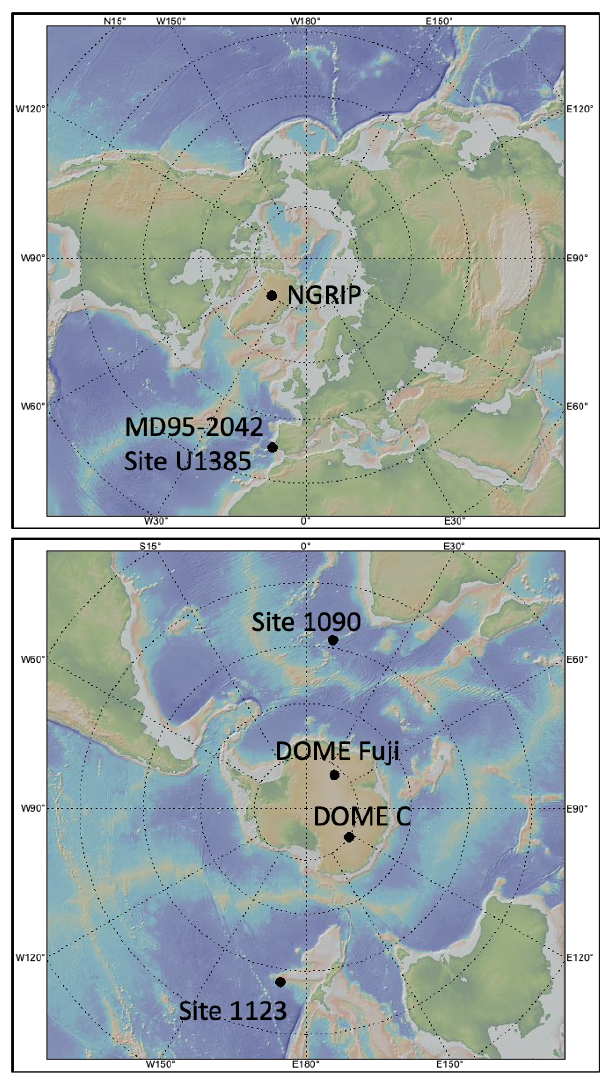
Figure 1. Location map. The maps show the locations of the ice and marine cores shown in this paper. Colours represent topogra- phy and bathymetry. Figure made with GeoMapApp (http://www. geomapapp.org, last access: 5 January 2022) / CC BY4.0 (Ryan et al.,